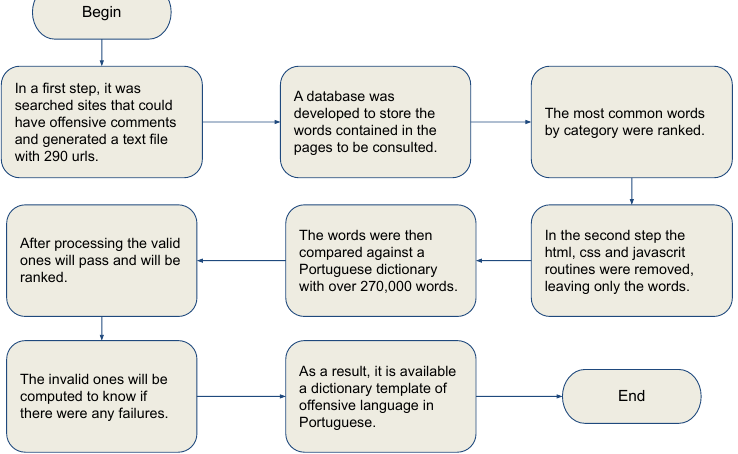
Figure 4. Flow to create the initial template of a hybrid dictionary model for offensive language